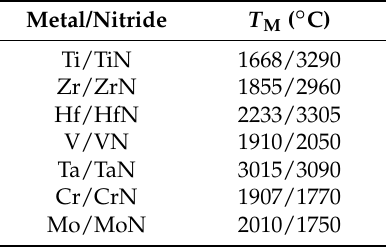
Table 1. Comparison of the melting temperatures ( T M ) of some transition metals and their